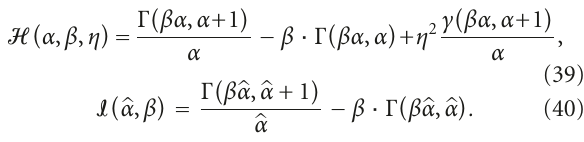
a low-kurtosis signal is greater than that for a high-kurtosis signal (see Figure 10(b)), the noise reduction performance of BF+SS is superior to that of